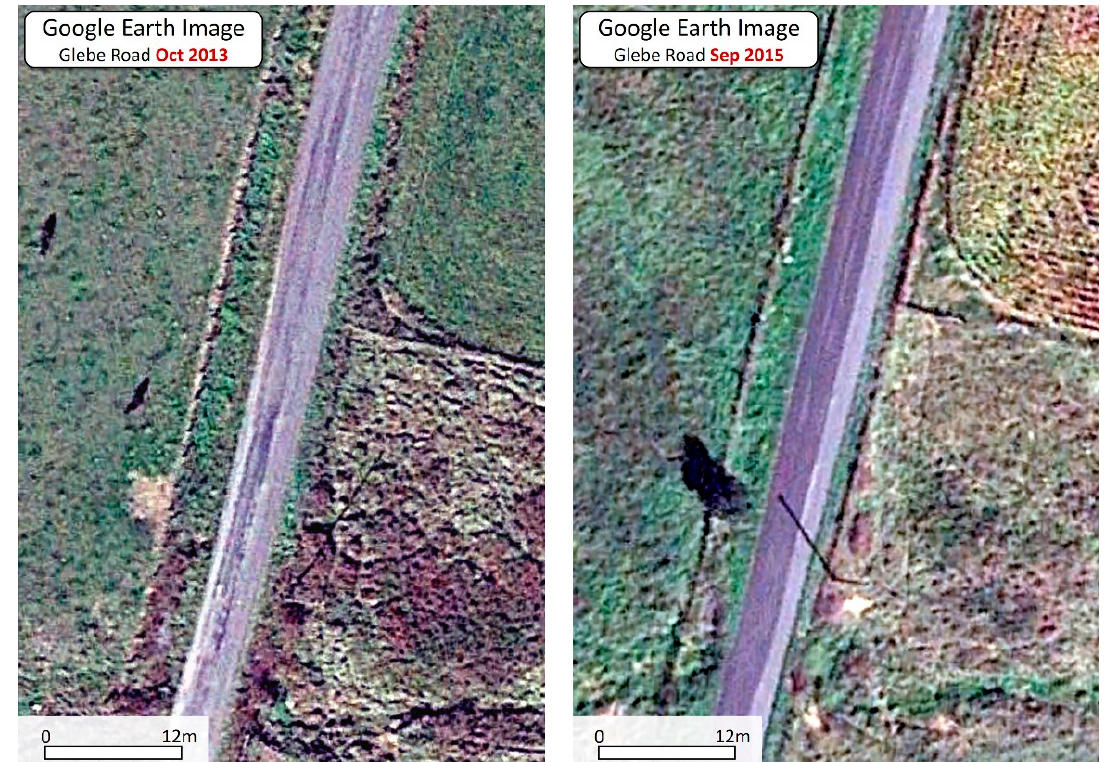
Figure 10. Comparison of the pavement conditions on Glebe School Road in October 2013 and September 2015. Significant rutting can be seen in the October 2013 image (left panel) increasing road surface roughness. This rutting appears largely mitigated in the September 2015 data set (right panel) due to the emplacement of a new pavement on the western side of the road. Image data provided by Google Earth. The location of these images is indicated by the rectangle in Figure 9b.